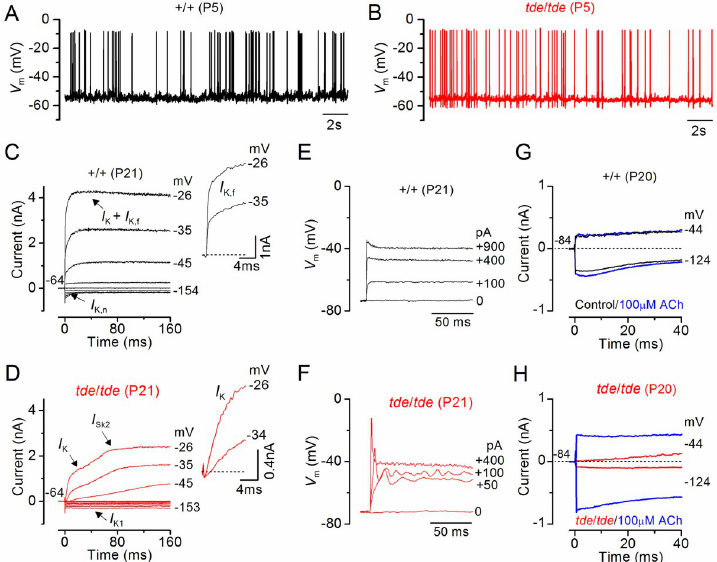
Fig 6. IHC current and voltage responses in Tasmanian devil mice. A and B , Spontaneous Ca 2+ dependent action potentials recorded from a control ( A : black line) and a tde / tde ( B : red line) P5 IHC. C and D , Currents from a control and a tde / tde adult P21 IHC, respectively, were elicited by depolarizing voltage steps in 10 mV nominal increments from –154 mV to the various test potentials shown by some of the traces; the holding potential was –64 mV. The insets show the same current recordings on an expanded scale (first 25 ms), note that the rapidly activating I K,f is only present in control cells whereas an inward current ( I Ca ) precedes the activation of the much slower K + current ( I K ) in tde / tde IHCs. E and F , Voltage responses induced by depolarizing current injections (the level is indicated to the right of the traces) applied to a control and a tde / tde adult IHC, respectively. Note that the tde / tde IHC showed a large initial spike followed by membrane potential oscillations compared to the graded responses of the control cell. G and H , Membrane currents recorded from an adult control and tde / tde IHC, respectively, in response to a hyperpolarizing and a depolarizing voltage step from the holding potential, before (black/red traces) and during superfusion of 100 μ M ACh (blue traces). Current responses were obtained at room temperature while voltage recordings were made at body